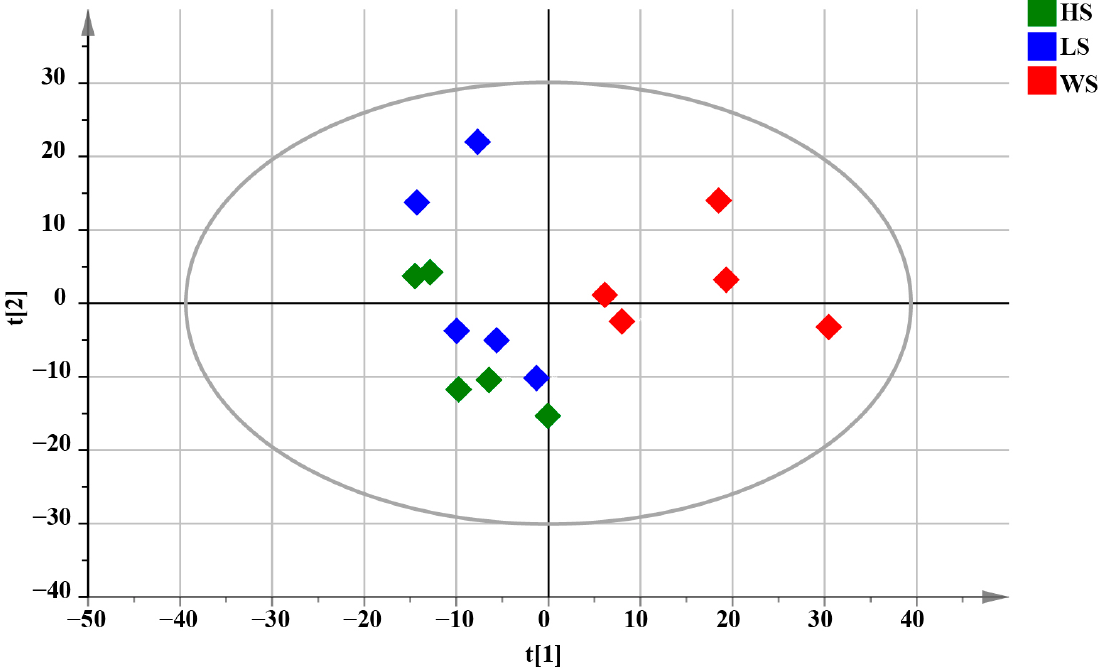
Figure 6. PCA score plots of total samples for MD with different levels of SF, R 2 X = 0.631.